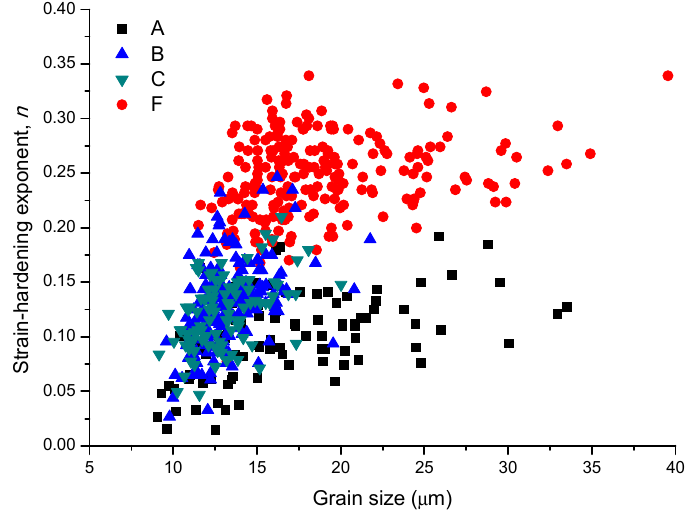
Figure 6. Distribution of the strain-hardening exponents ( n ) of the individual grains of ferrite, obtained from Equation (5), plotted as a function of the individual grain size. Where: A = straight stretch, B = Intrados , C = Extrados and F = straight stretch normalized at 900 °C.